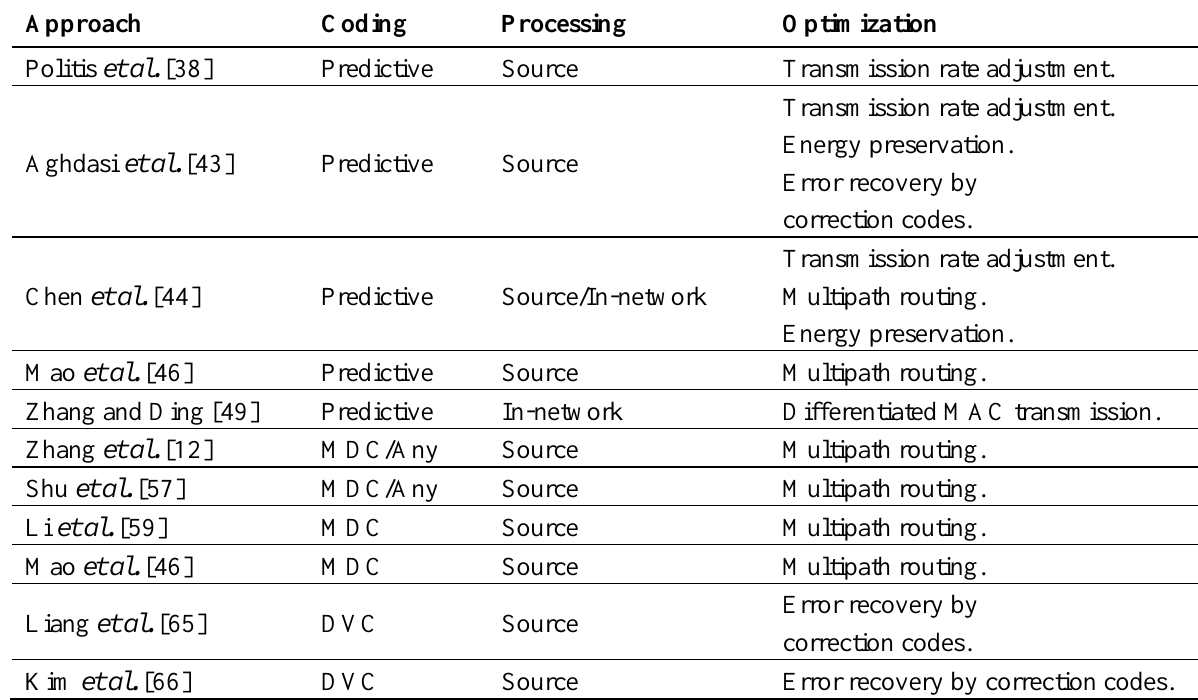
Table 2. Video-based cross-layer